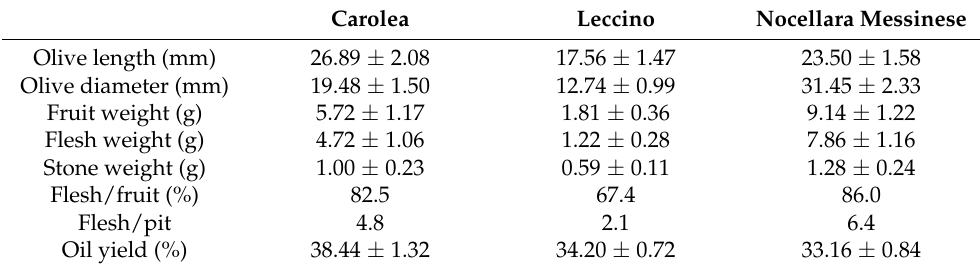
Table 1. Carpological characteristics of olive drupes.